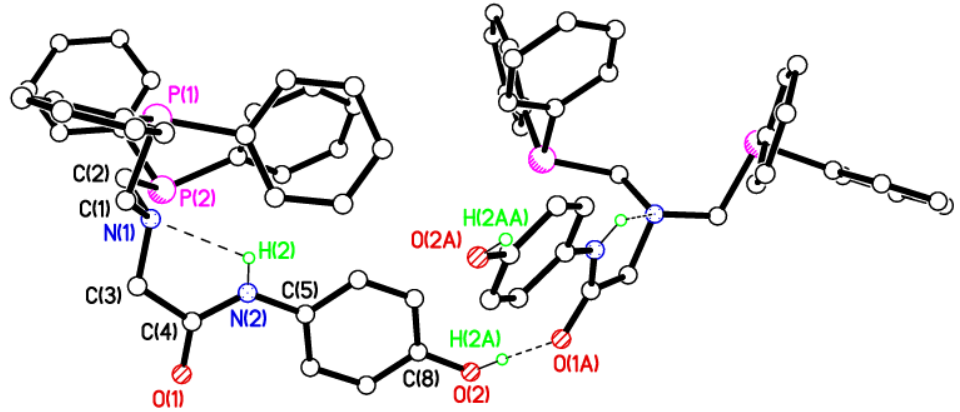
Figure 4. Dimers of 2f forming R 2 2 (16) graph set motifs. Most H atoms omitted for clarity. The second unique molecule which adopts a similar, centrosymmetric motif, is not shown.